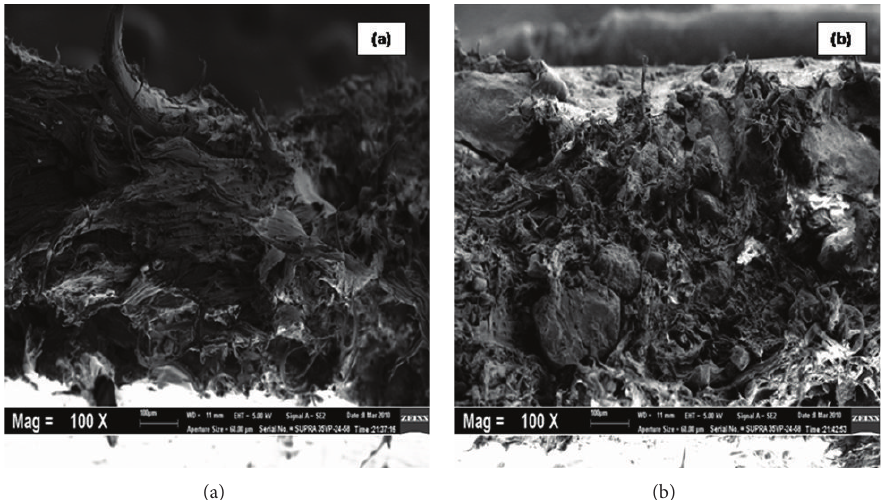
Figure 6: Tensile fracture surfaces of (a) 5 wt% EVA/zeolite and (b) 25 wt% EVA/zeolite.